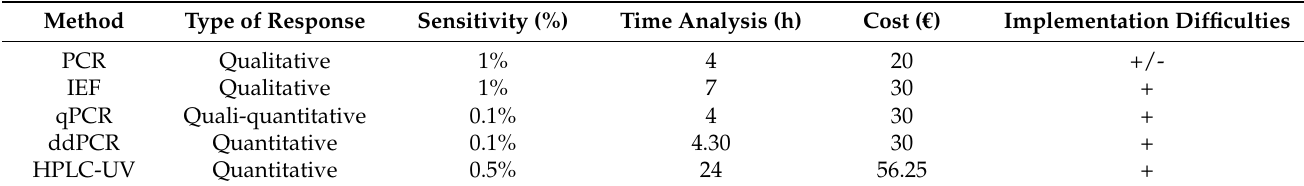
Table 4. Differences between individual methods of